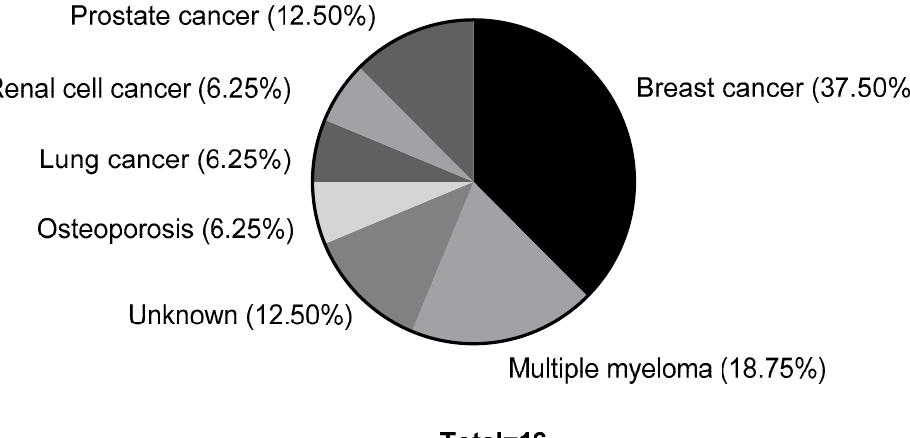
Figure 4. Etiology of MRONJ: six patients with breast cancer, three patients with multiple myeloma, two patients with prostate carcinoma, and one case each of renal cell carcinoma, lung cancer, and osteoporosis. In two cases, the reason for medication intake is unknown.